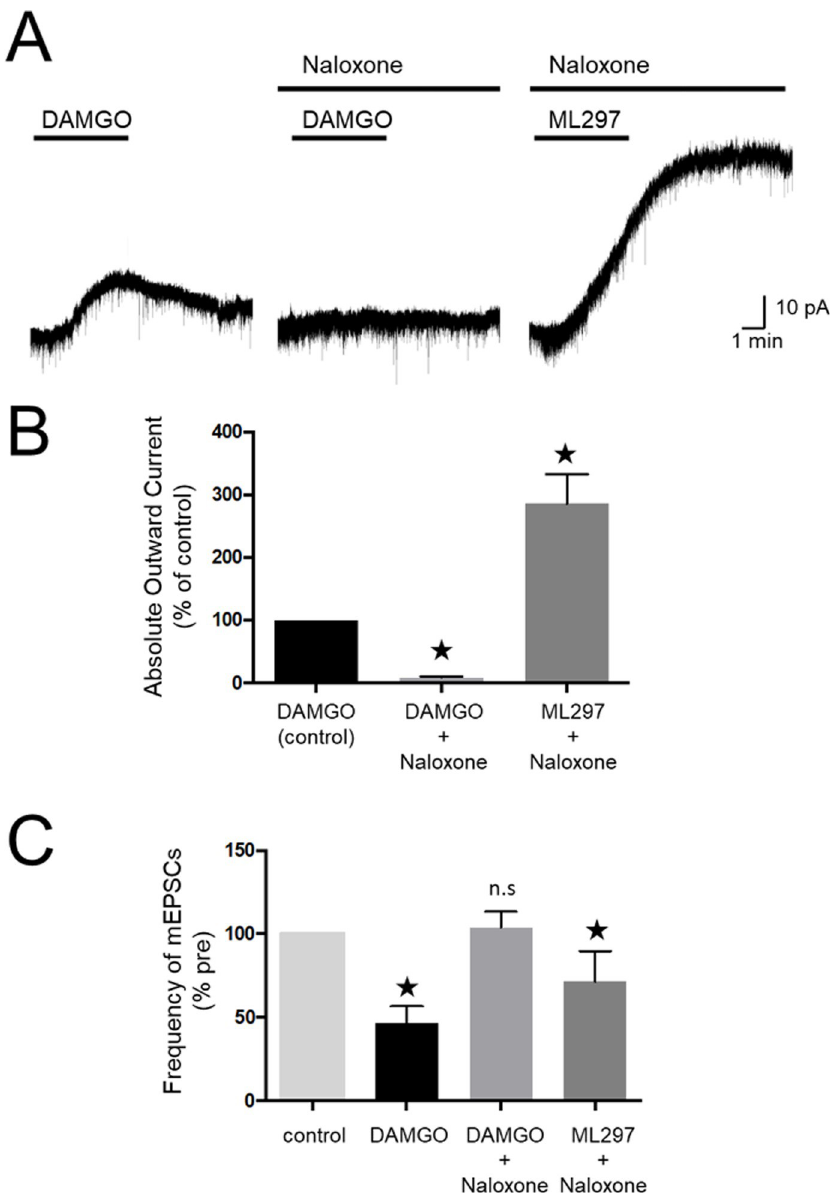
Fig 5. Effects of naloxone on presynaptic and postsynaptic actions of ML297. (A) Representative recording of currents applied by DAMGO in the absence (left) and presence (middle) of naloxone and currents applied by ML297 in the presence of naloxone (right). The readings were obtained from the same neuron (n = 7, V H = -70 mV). (B) Summary of normalized amplitudes of DAMGO and ML297-induced outward currents. The peak of the DAMGO- induced current was set as a reference value (control). (C) Summary of normalized frequencies of mEPSCs for each condition. Data in (B) and (C) are mean ± SEM (n = 7, each). $ P < 0.05, n.s.; not significant.